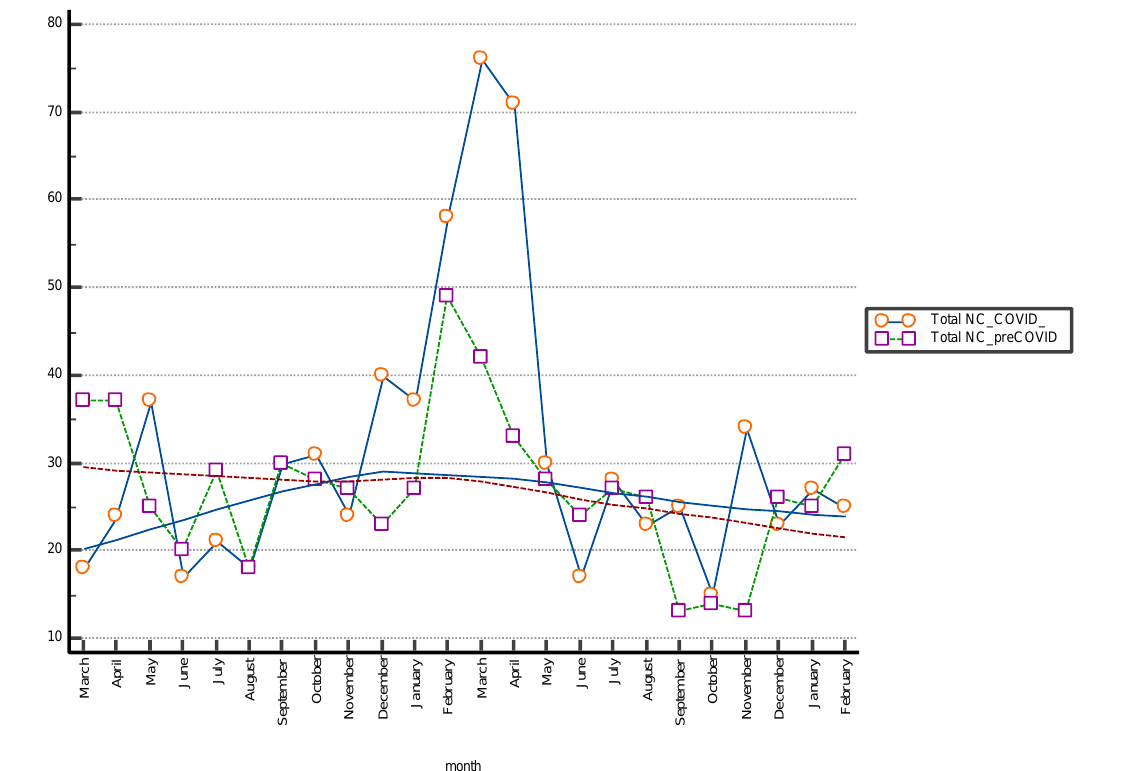
Figure 2. The Multiple line graph shows the number of total non-conformities (NC) differentiated by month of observation; period March 2018–February 2022. The moving average trend lines are indicated. Table 2. Comparison of the difference between the means of total NC or differentiated according to the type encountered in the pre-COVID vs. COVID periods (Mann – Whitney test).